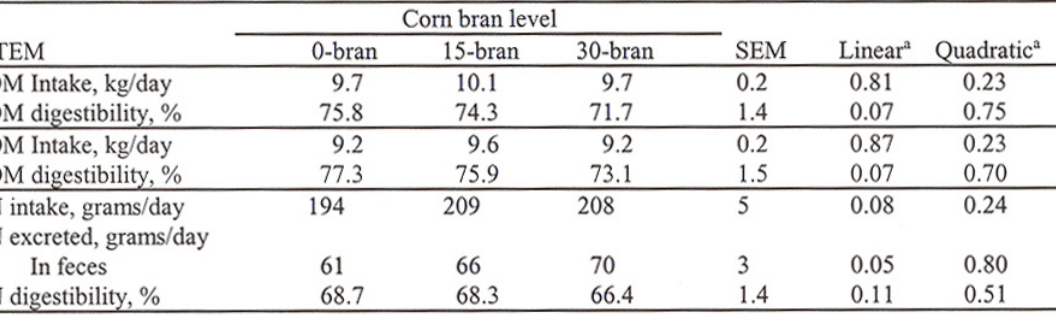
DM, OM, and N Digestibility Results from Replicated Latin Square Digestibility Trial Using Ruminally and Duodenally Cannulated